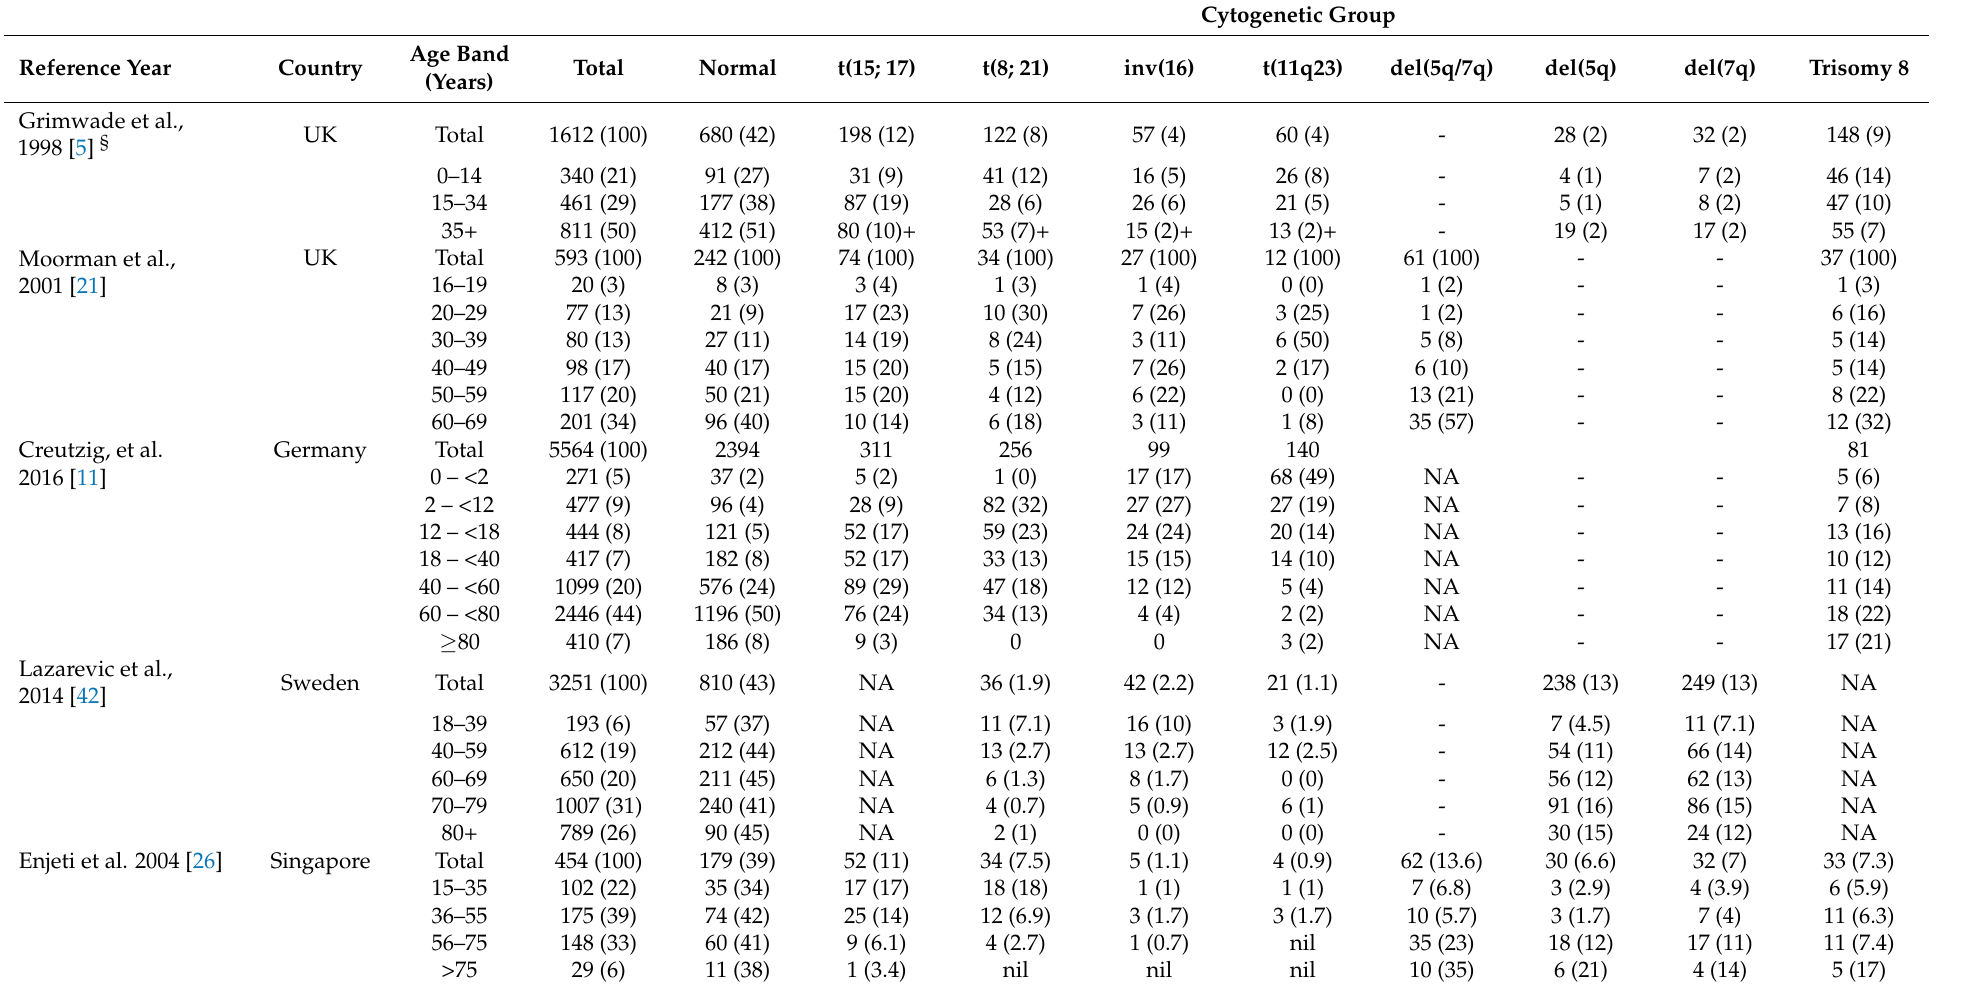
Table 6. Number (%) of AML patients by age and cytogenetic profiles based on published studies.